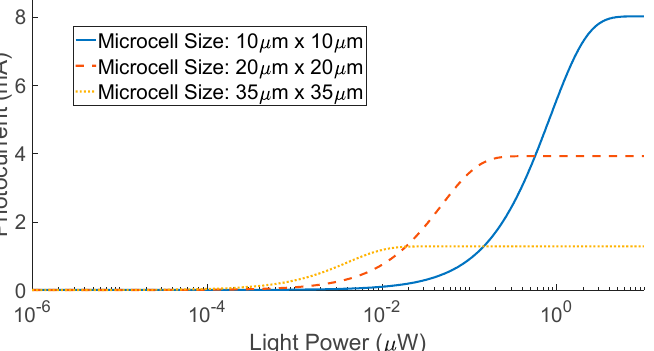
Figure 9. Input optical power versus corresponding photocurrent generated by the OnSemi C − Series (1 mm × 1 mm) with different microcell sizes, 10 µ m, 20 µ m and 35 µ m, respectively. The total number of cells in each device is 2880, 1296 and 504, respectively.